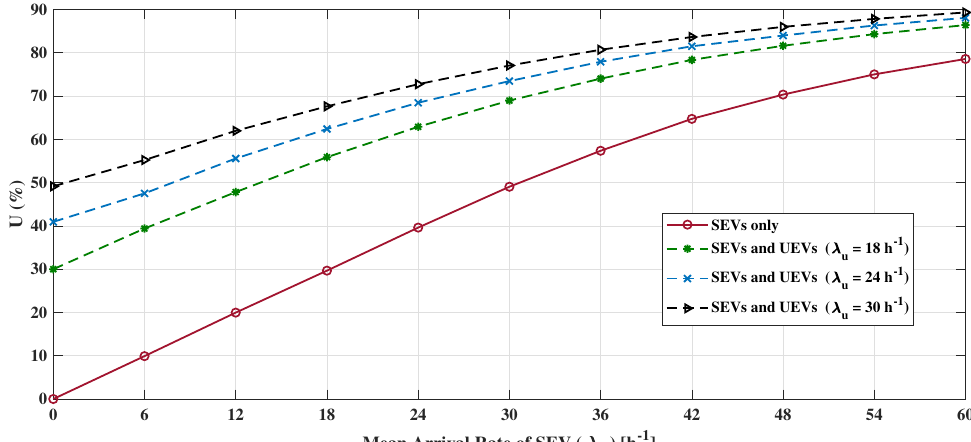
Figure 4. Charging resource utilization with λ s .